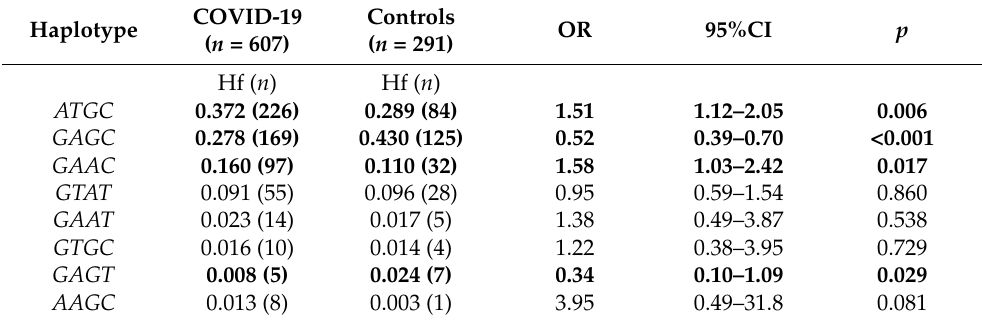
Table 3. Frequencies of TMPRSS2 haplotypes in the studied groups.